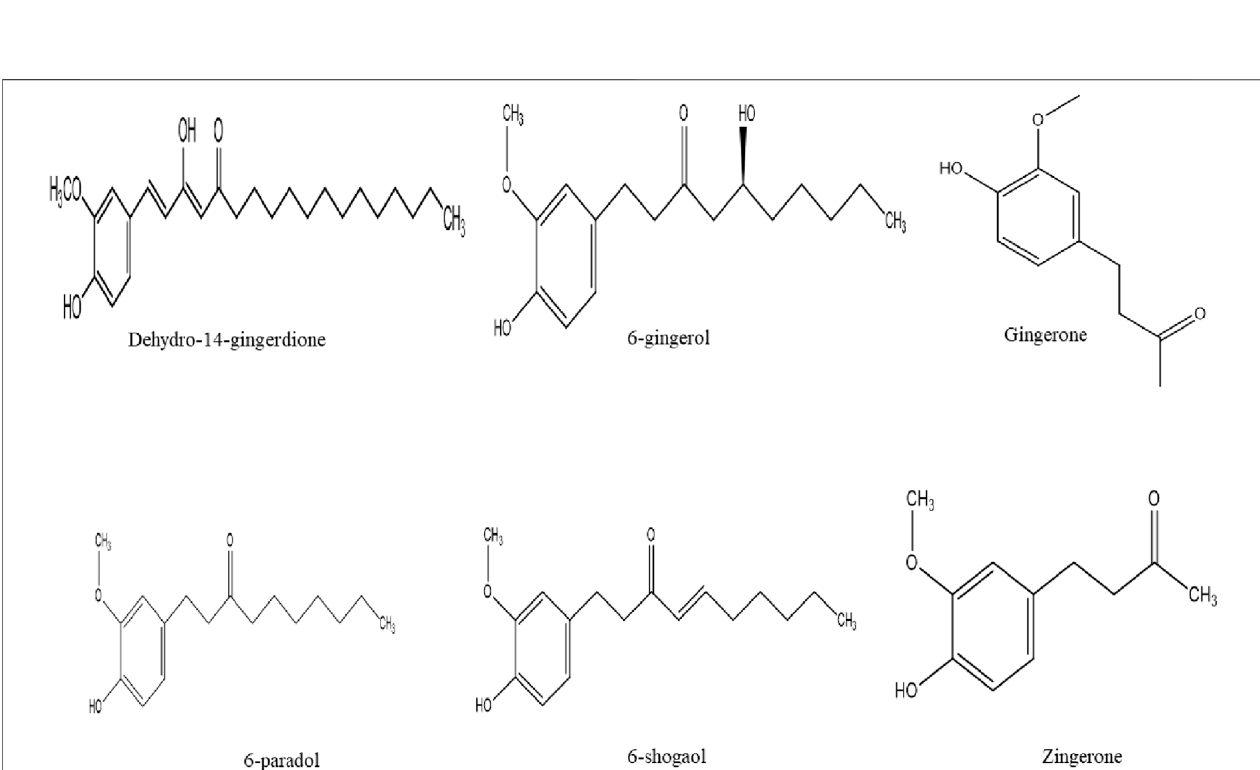
FIGURE 2 | Chemical structures of gingerol analogues compounds isolated from ginger.